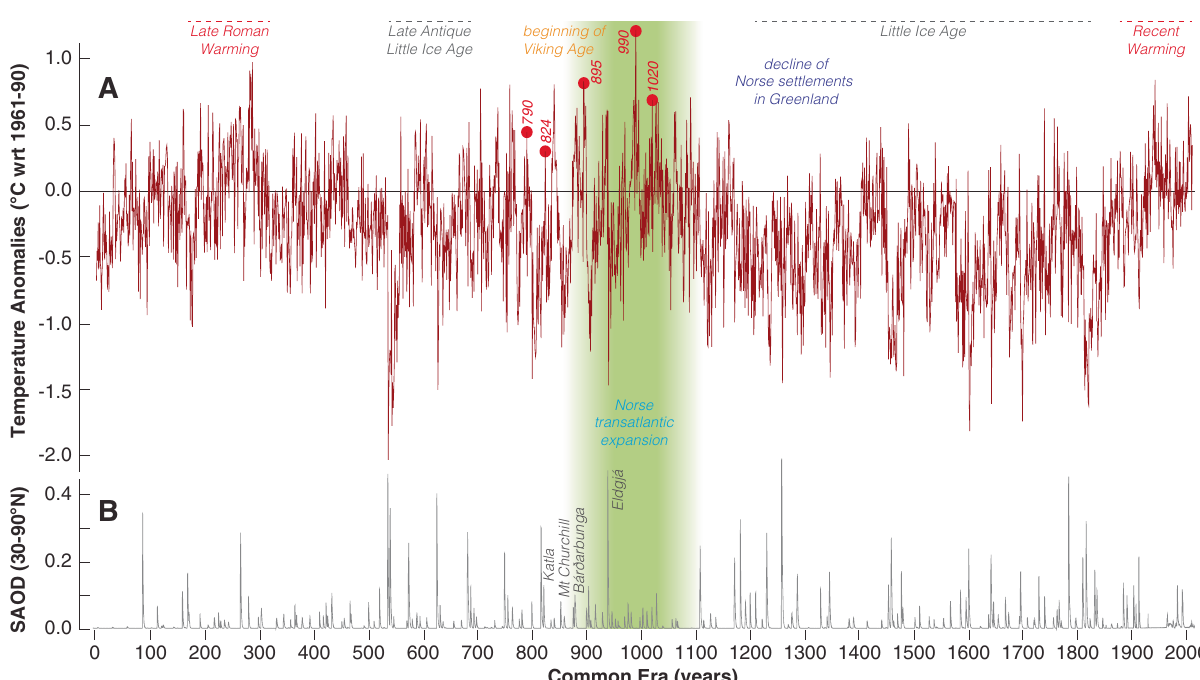
Fig. 1 Climate and volcanism in the Viking Age. A Summer temperature reconstruction for the North Atlantic/European sector 7 , revealing peak warming from the beginning of the Viking Age in the 790 s throughout the Norse occupation of the Faroes, Iceland, Greenland, and Vinland from the 9 th to the 11 th century CE. B Stratospheric Aerosol Optical Depth (SAOD) for the Northern Hemisphere extra-topics associated with volcanic dust veils and estimated from ice core records 14